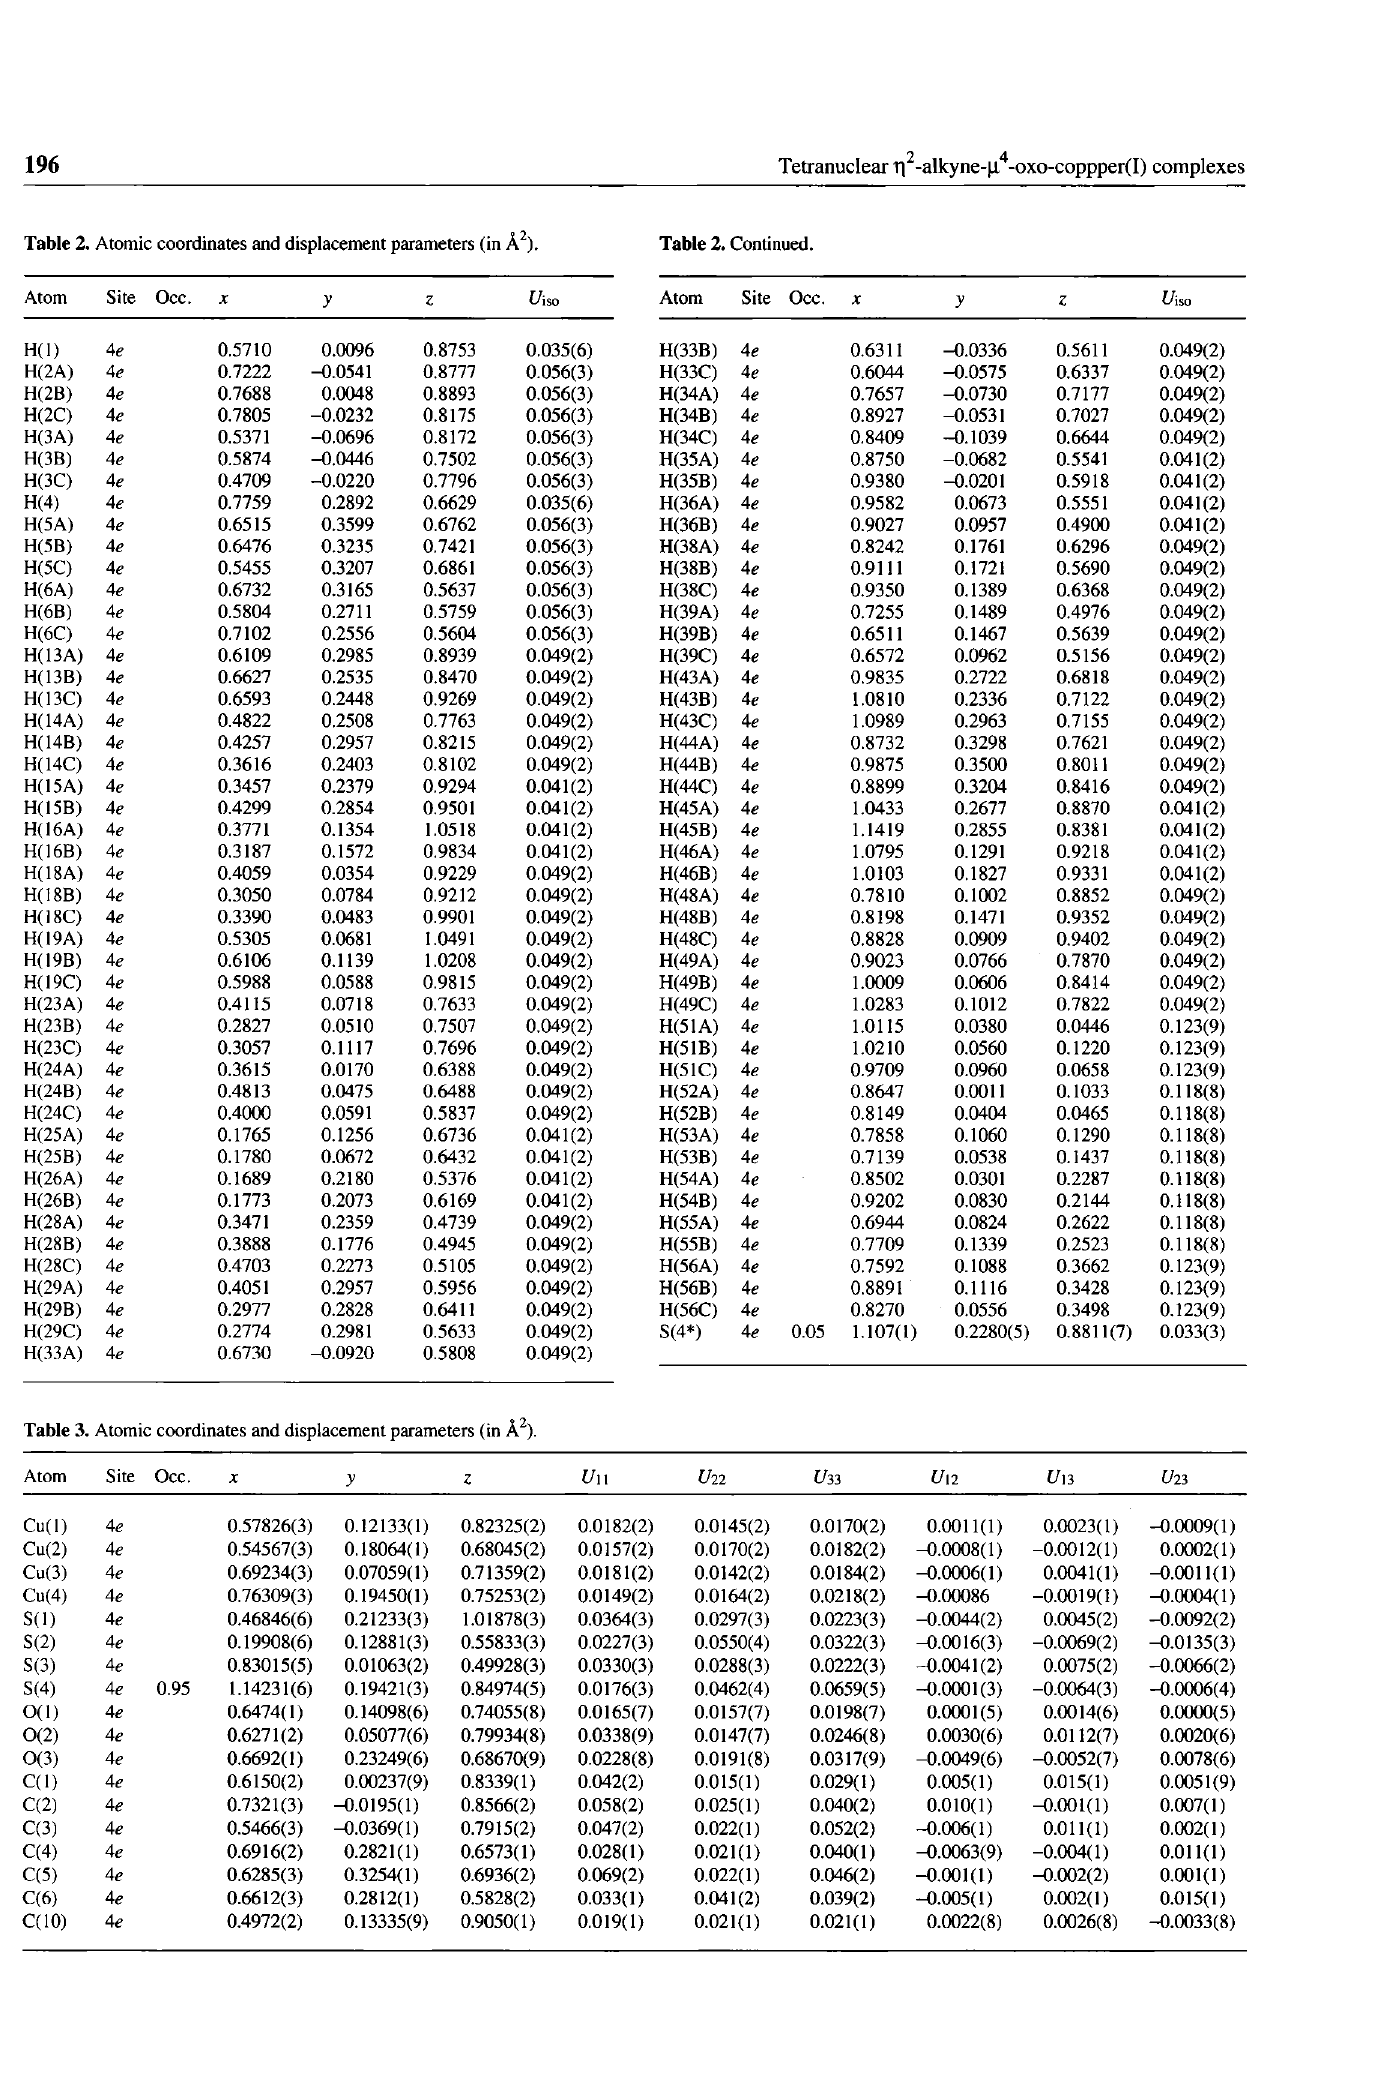
Table 3. Atomic coordinates and displacement parameters (in Ä 2